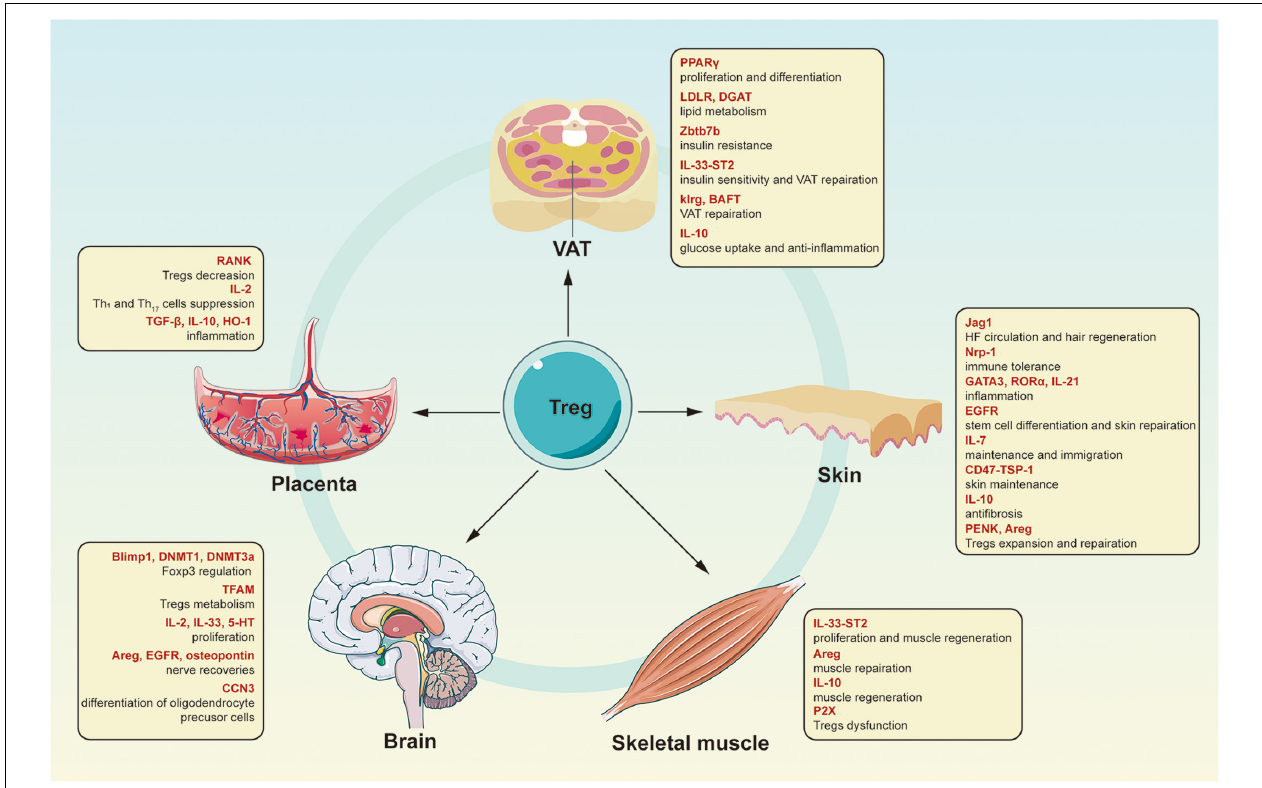
FIGURE 1 | Characteristics of different kinds of tissue Tregs. Tregs are not only critical for affecting immune response, but also for maintaining non-lymphoid tissues homeostasis via different cytokines or interacting with other tissue cells. Tregs, regulatory T cells; PPAR γ , peroxisome proliferator-activated receptor gamma; LDLR, low-density lipoprotein receptor; DGAT, diacylglycerol O -acyltransferase; Zbtb7b, Zinc finger and BTB domain-containing protein 7B; IL-33, interleukin-33; ST2, IL-1 receptor-like 1; klrg1, killer cell lectin-like receptor subfamily G1; BATF, basic leucine zipper ATF-like transcription factor; IL-10, interleukin-10; Jag1, the Notch signaling ligand Jagged1; Nrp1, neuropilin 1; GATA3, GATA binding protein 3; ROR α , retinoic acid-related orphan receptor alpha; IL-21, interleukin-21; EGFR, epidermal growth factor receptor; IL-7, interleukin-7; TSP-1, thrombospondin-1; PENK, proenkephalin; Areg, amphiregulin; P2X, purinergic receptor P2X; Blimp1, B lymphocyte-induced maturation protein 1; DNMT1, DNA methyltransferases 1; DNMT3a, DNA methyltransferases 3 alpha; TFAM, mitochondrial transcription factor A; IL-2, interleukin-2; 5-HT, 5-hydroxytryptamine; CCN3, cellular communication network factor 3; RANK, NF- κ B ligand; TGF- β , transforming growth factor beta; HO-1, heme oxygenase